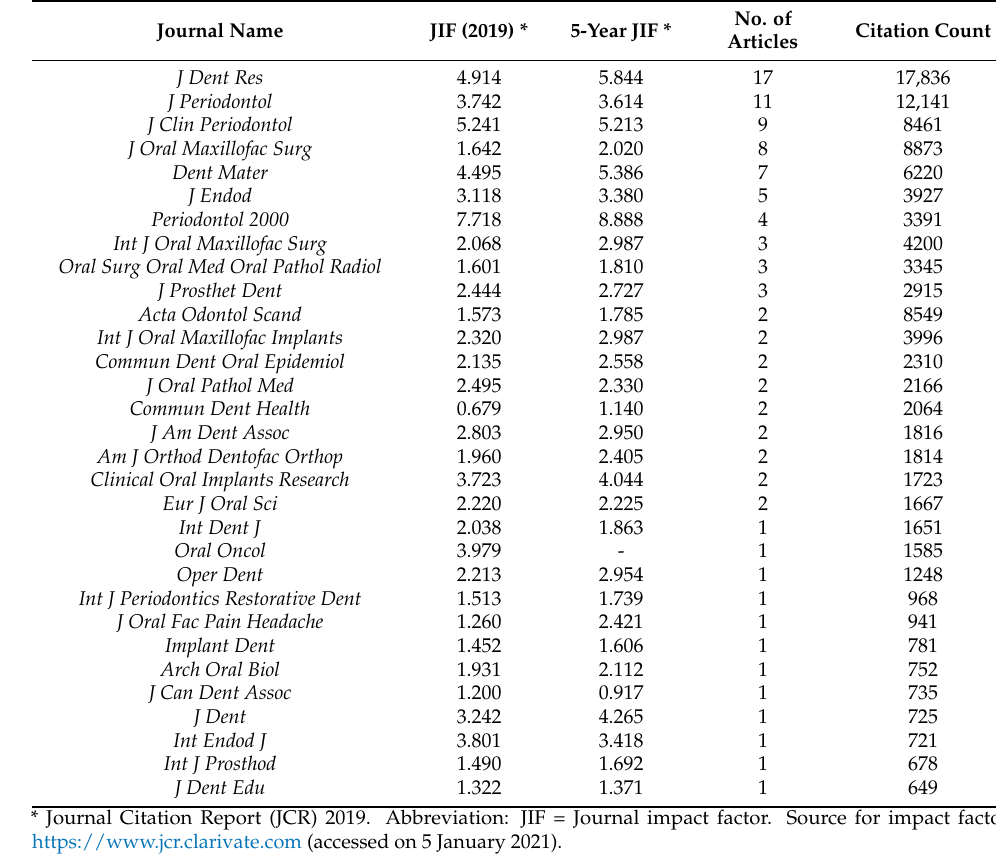
Table 2. List of journals in which the top 100 most-cited articles were